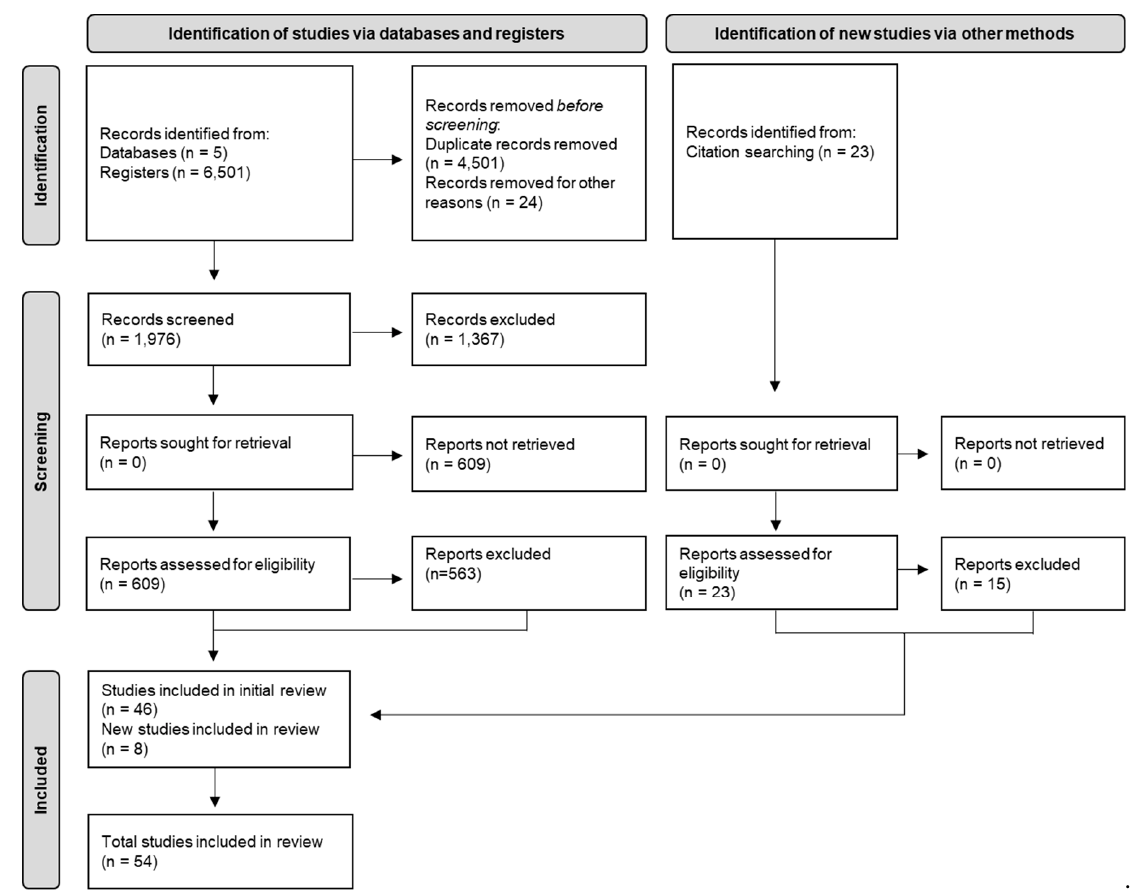
Figure 1. PRISMA 2020 flow diagram. Results overview. Source: Adapted from ref. [28].